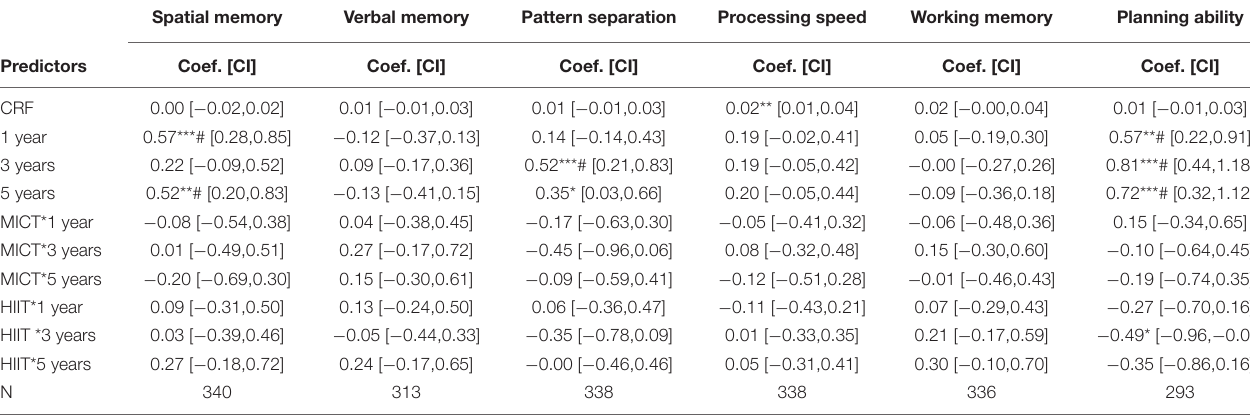
TABLE 6 | Results of the linear mixed model (Model 1) assessing group *time interaction, cardiorespiratory fitness (CRF), and time effects on cognitive test performance in the high intensity interval training group and moderate intensity continuous training group compared to the control group.